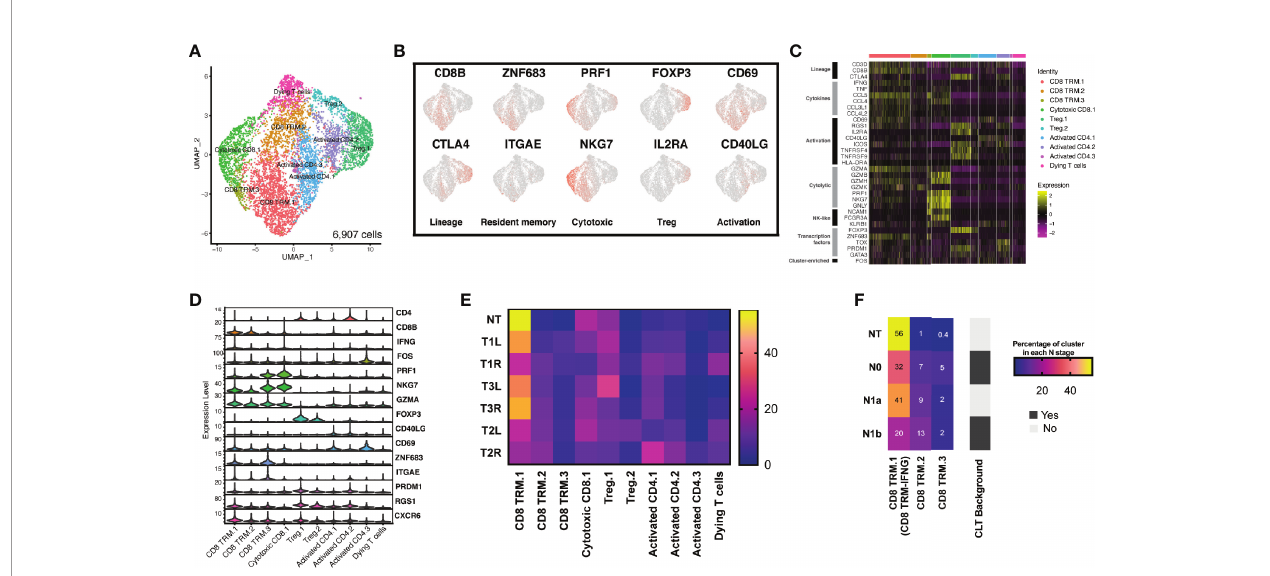
FIGURE 3 | The T-cell landscape of papillary thyroid carcinoma reveals transcriptionally heterogeneous cell populations. (A) Sub-clustering of T cells ( n = 6,907) showing transcriptional heterogeneity with both CD8 + and CD4 + T cells. Major groups of T-cell lineages labeled. (B) Uniform manifold approximation and projection (UMAP) feature plot representation of marker gene expressions with individually identi fi ed T-cell populations and phenotypic states. (C) Heatmap of T-cell lineages and functional markers providing phenotypic information for individual T-cell populations. (D) Violin plots showing the expression distributions of canonical marker genes in T-cell lineages. (E) Different T-cell populations were enriched in different thyroid samples. Heatmap representation of the proportion of each T-cell cluster from each sample. (F) CD8 TRM-IFNG T cells were enriched in non-tumor (NT) thyroid tissue, CLT, chronic lymphocytic